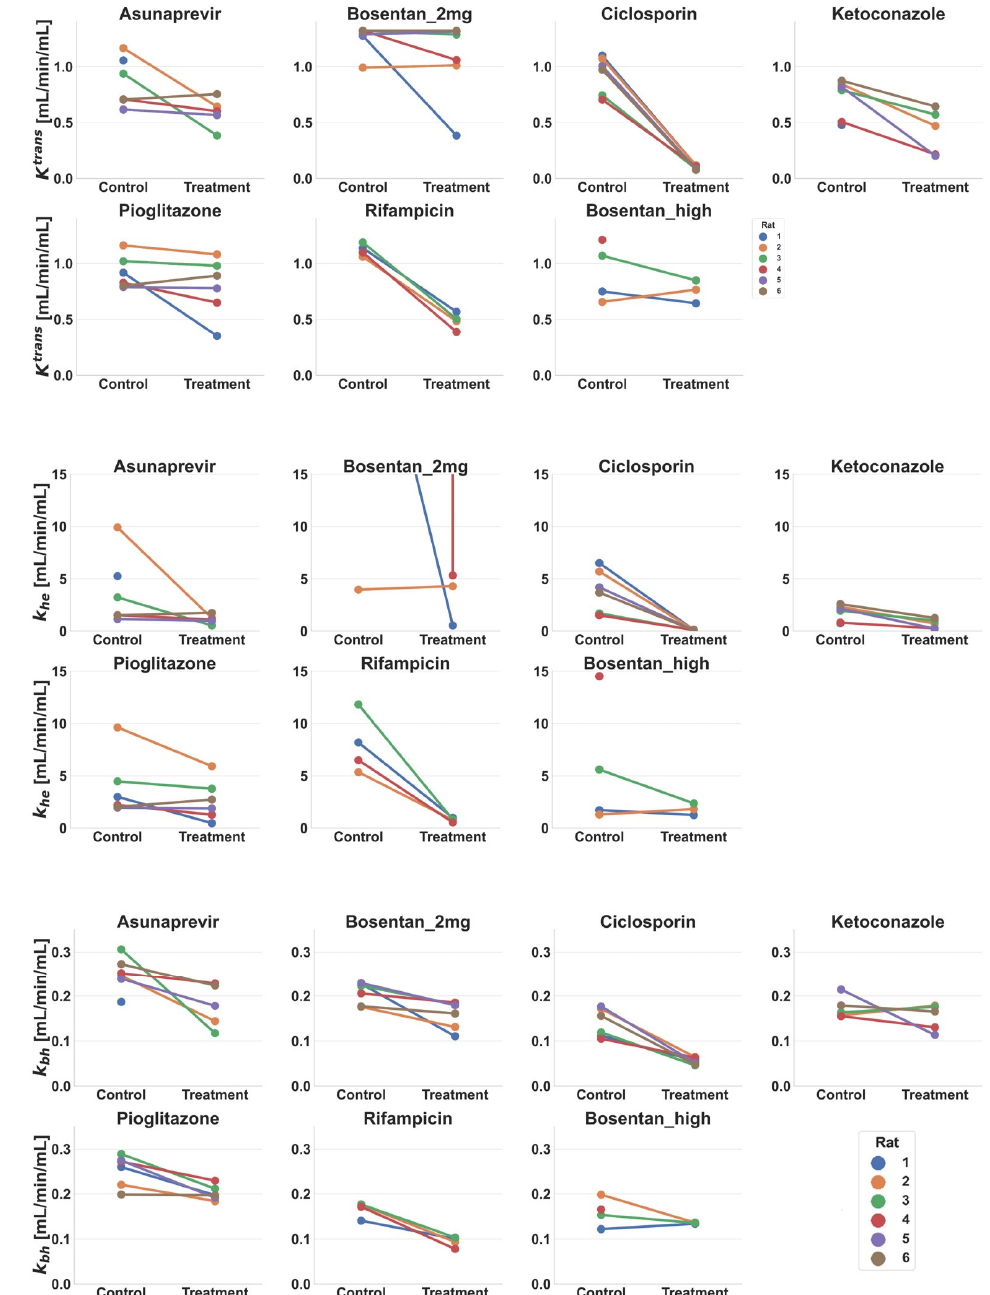
Figure 7. Effect of drug administration on estimated tracer-kinetic model rate constants for hepatic plasma clearance (K trans ), hepatic gadoxetate uptake (k he ), and biliary excretion (k bh ), for different sites (D, E, G1, and G2) and drugs. Each line represents a single rat. Doses for each drug are listed